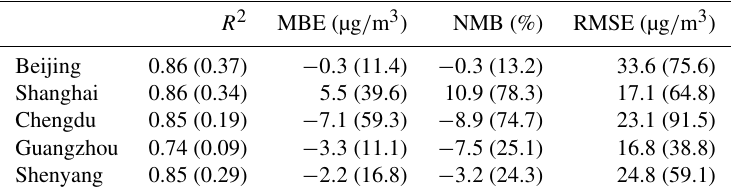
Figure 8. Same as Fig. 7 but for the PM 10 concentration. Table 4. Independent validation results of the CAQRA dataset (outside brackets) and base simulation (inside brackets) against the observation data retrieved from the US Department of State Air Quality Monitoring Program over China on an hourly